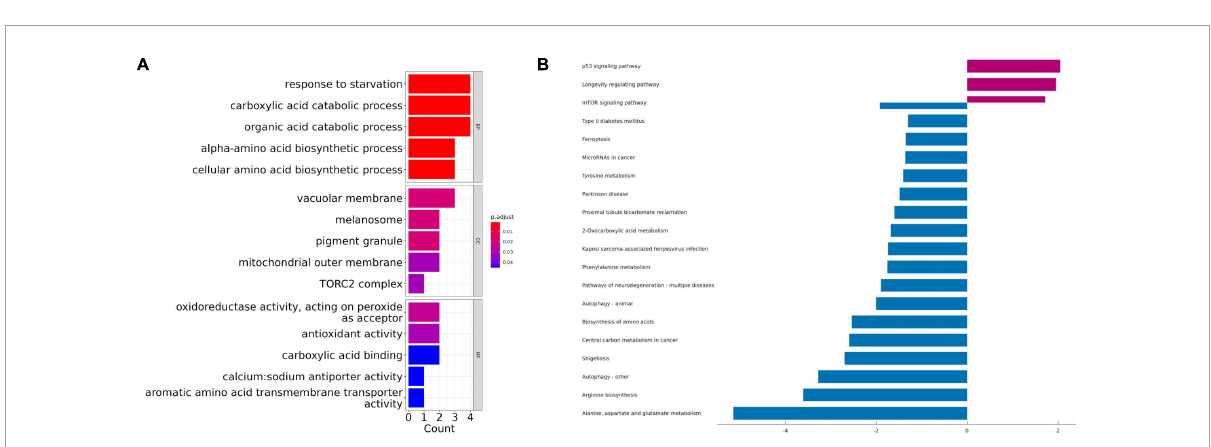
FIGURE3 The Gene Ontology (GO) and Kyoto Encyclopedia of Genes and Genomes (KEGG) enrichment analyses using the top 10 ranked ferroptosis-related DEGs. (A) Gene Ontology (GO) functional analysis shows enriched items in the top 10 ranked ferroptosis-related DEGs. (B) Kyoto Encyclopedia of Genes and Genomes (KEGG) analysis shows the enriched items in the top 10 ranked ferroptosis-related DEGs. BP, biological process; CC, cellular component; MF, molecular function.